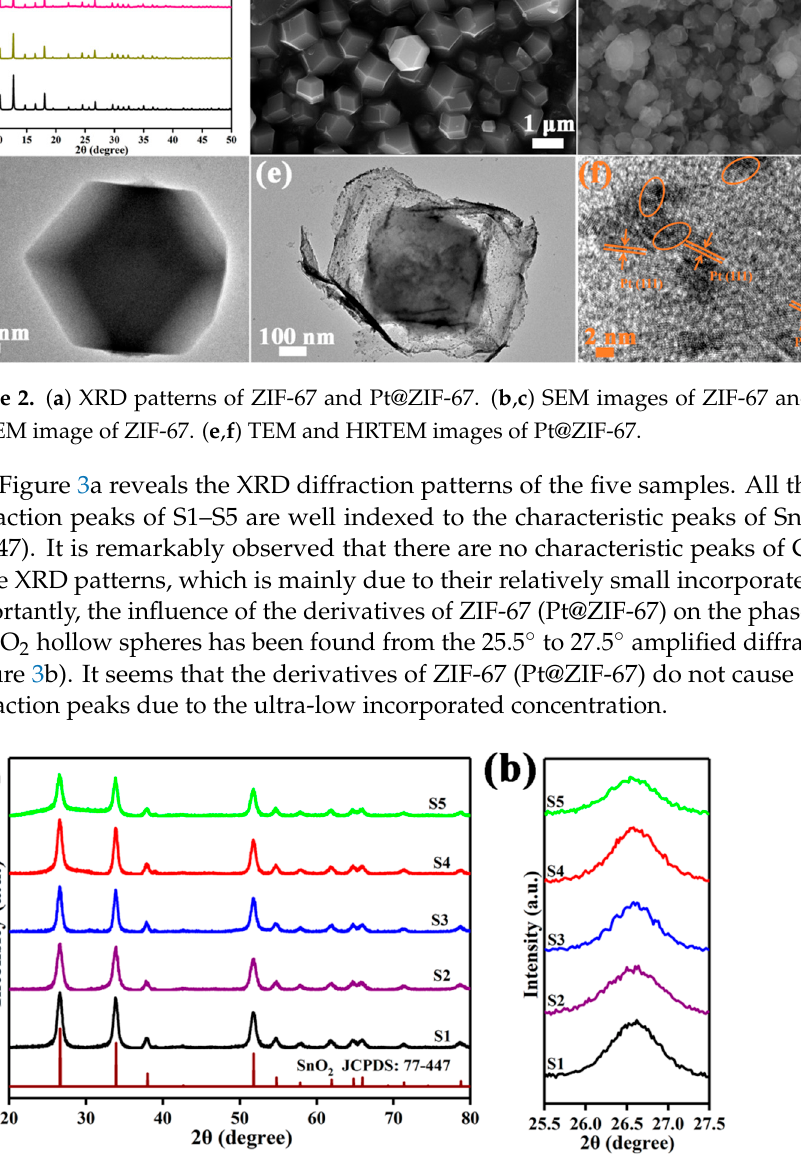
Figure 3. ( a ) XRD analysis of S1–S5. ( b ) The close spectrum of diffraction peaks between 25.5° and 27.5° in